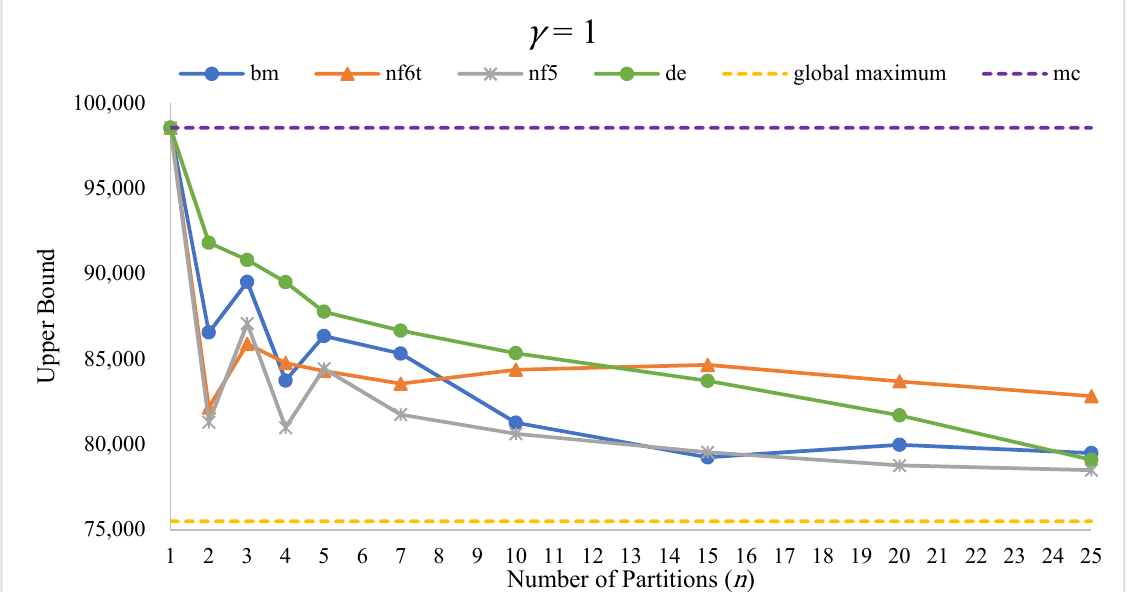
Figure 6. Convergence-indicating curves of the bm , de , nf5 , and nf6t relaxation schemes for 𝛾 = 1.